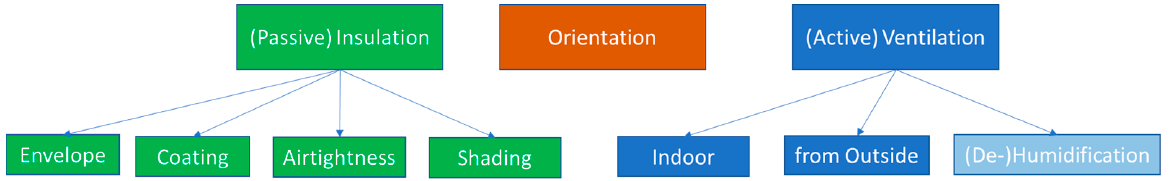
Figure 1. Output Pillars of the Passivhaus for a tropical Building.